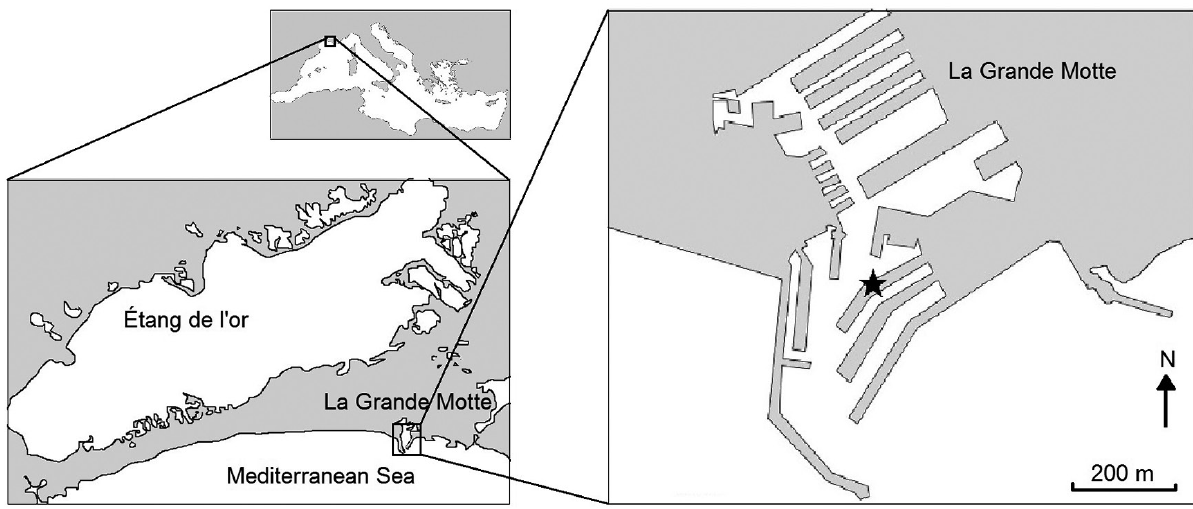
Fig. 1. – La Grande Motte marina on the Mediterranean coast of southern France. The pontoons that were sampled lie beneath the boardwalk indicated with a star.